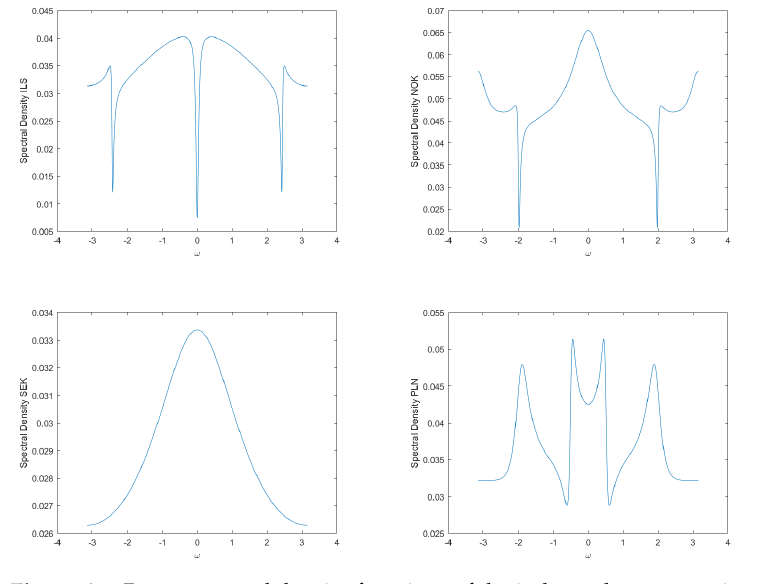
Figure A3. Power spectral density functions of the independent currencies.